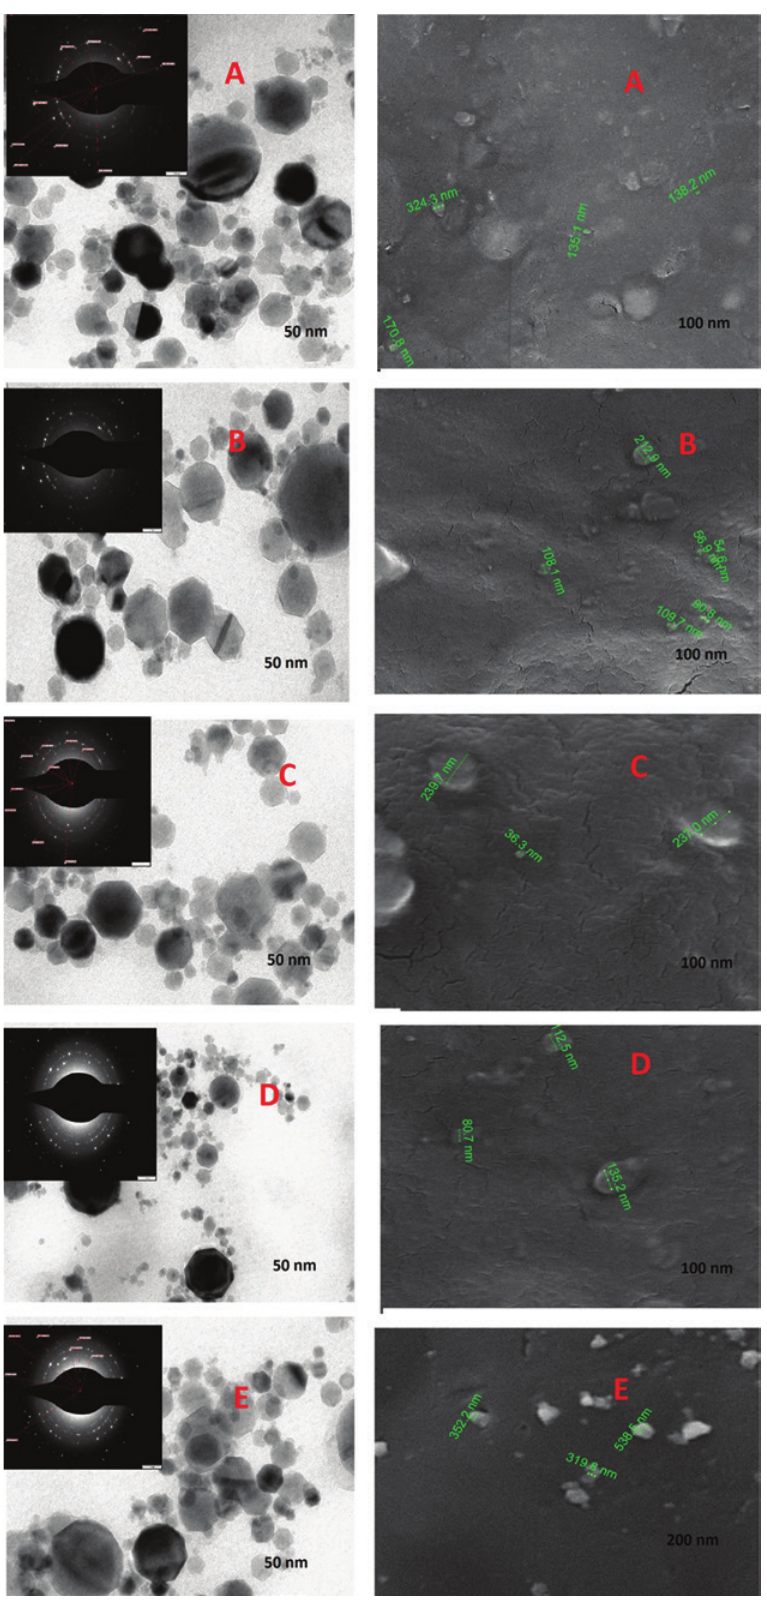
O nanoparticle (B) blend + 1 wt% Fe 2 3 O 2 3